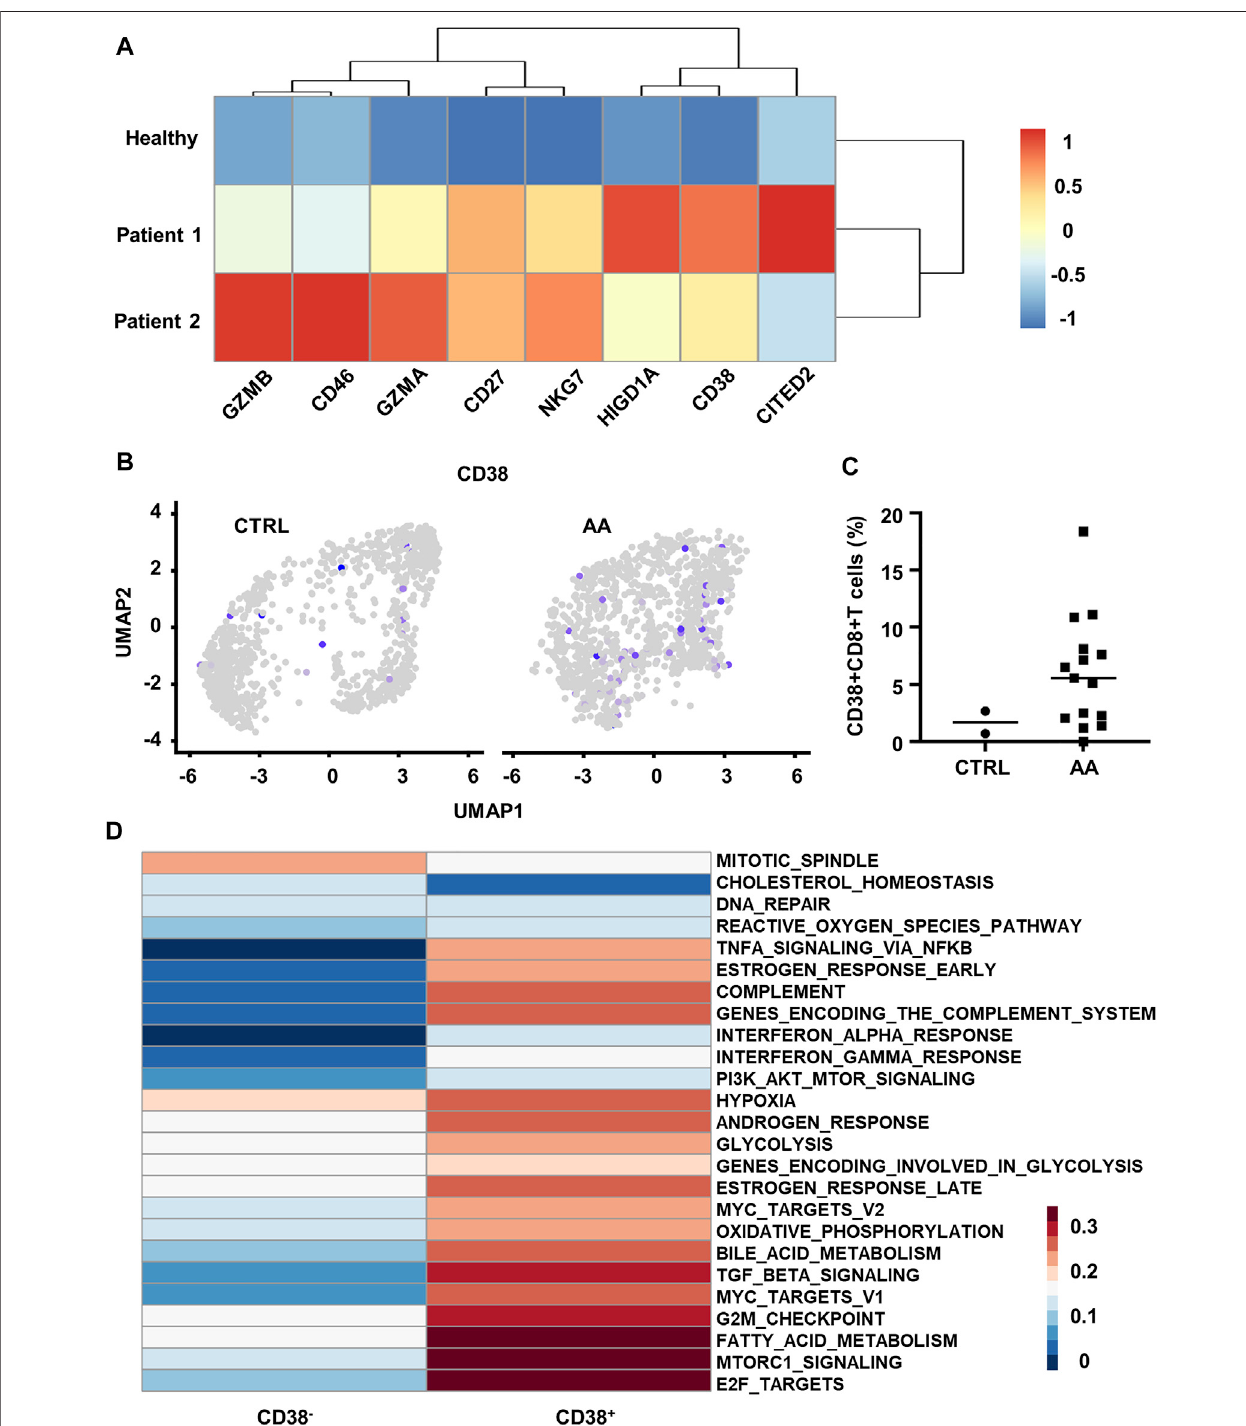
FIGURE 4 | Transcriptional and scRNA-seq analysis reveals increased CD38 + CD8 + T cells in AA patients. (A) Heatmap showing differential genes between BM T cells from healthy control (GSM87365), Patient 1 (SAA patient, GSM87341), and Patient 2 (SAA patient, GSM87360) in microarray data (GSE3807). (B) Feature plot showing theexpression of CD38in CTRLand AA. (C) Scatter plotshowingthe proportion ofCD38 + CD8 + Tcells (expression value > 0) inCD8 + Tcells from CTRL( n (cid:1) 2) and AA patients ( n (cid:1) 15). (D) GSVA heatmap showing hallmark pathways enriched in CD38 + and CD38 − cells. CD38 + cells were de fi ned by the expression level of CD38 gene. AA, aplastic anemia; BM, bone marrow; CTRL, healthy control; GSVA, gene set variation analysis.